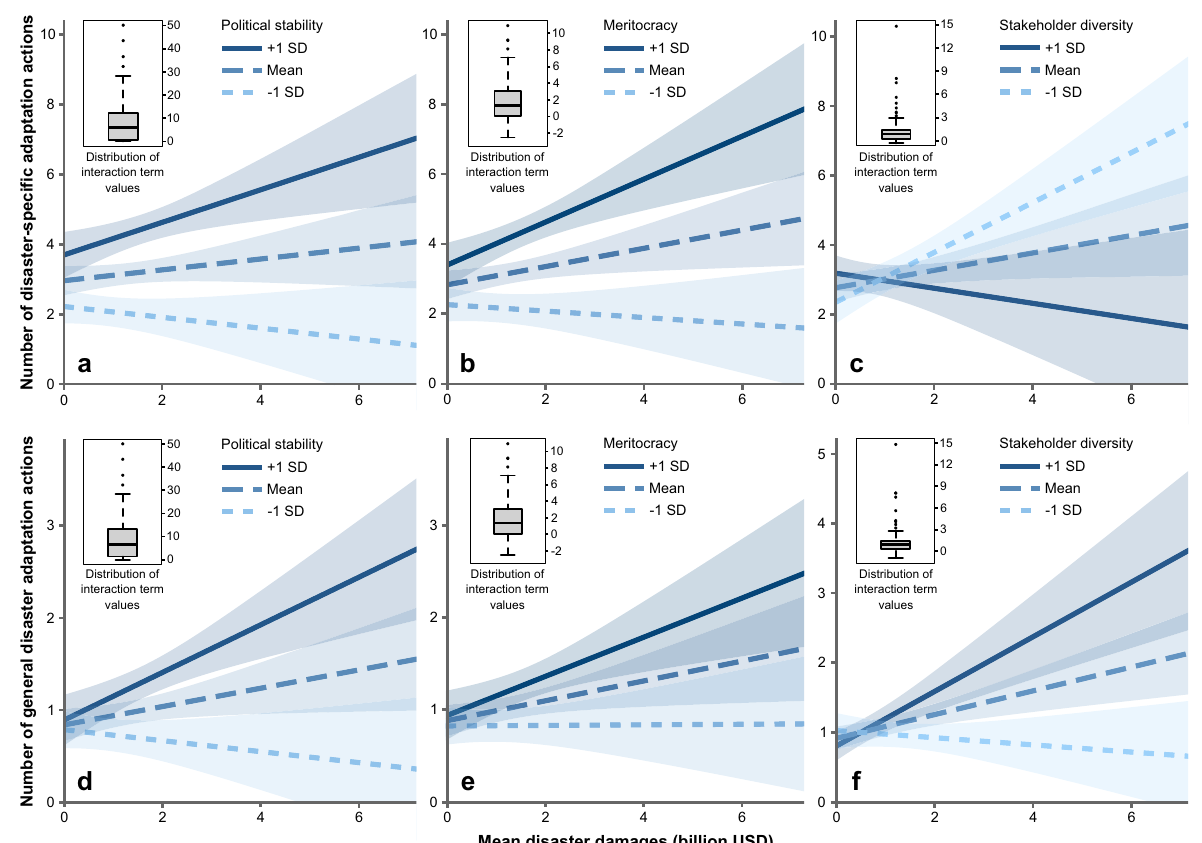
Fig. 3 Results of simple slopes analyses. Top row panels show results of simple slopes analyses of the strength of the relationship between economic damages and speci fi c adaptation actions at high ( + 1 SD), mean, and low ( − 1 SD) levels of political stability ( a ), meritocracy ( b ), and stakeholder diversity ( c ). Bottom row panels show the relationship between economic damages and general adaptation actions at high ( + 1 SD), mean, and low ( − 1 SD) levels of political stability (panel d ), meritocracy ( e ), and stakeholder diversity ( f ). The coloured bands denote the 90% con fi dence